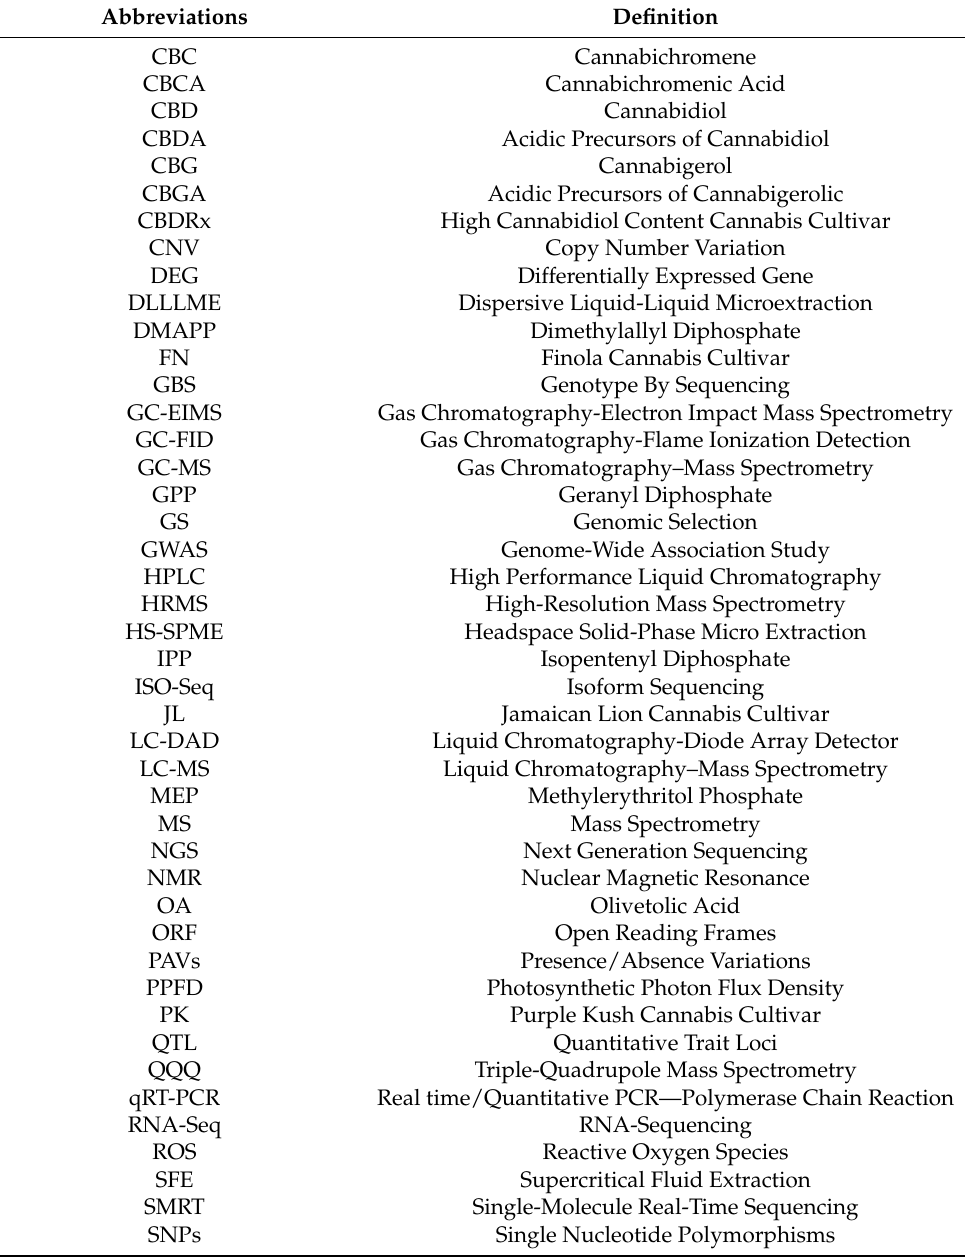
Table 1. List of abbreviations used in this